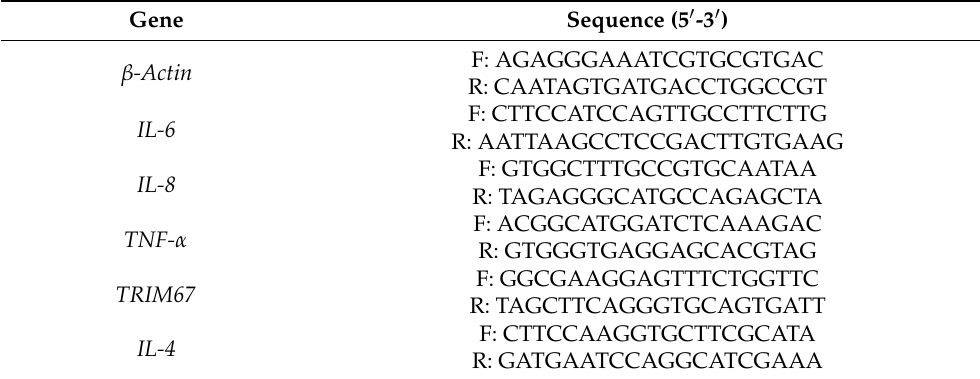
Table 2. The primers used for the RT-qPCR